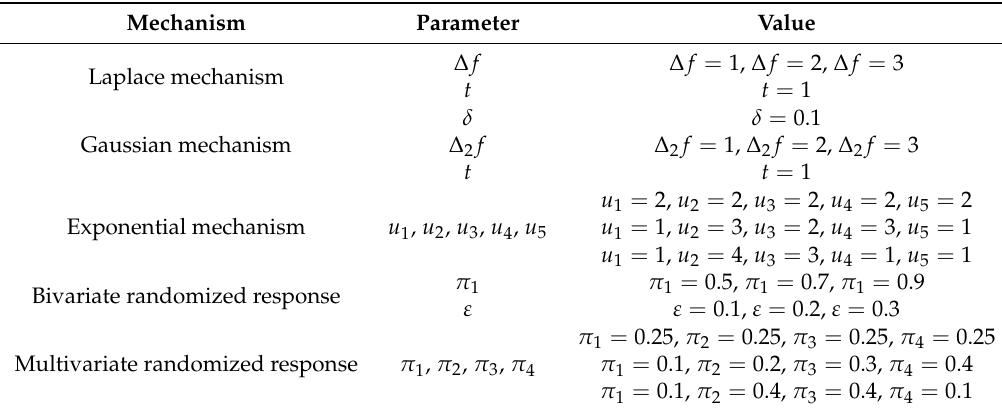
Table 2. Parameter